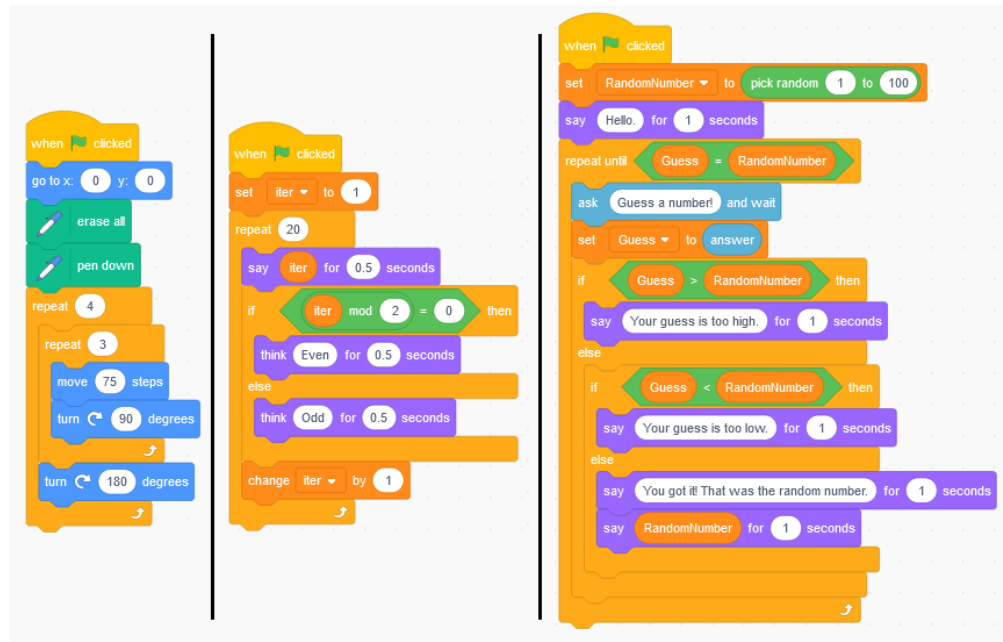
Figure A1. The three original algorithms that the Generic Tasks were derived from ( left ). Plus: The sprite draws a plus sign (middle ). Odd–Even: The sprite goes through the numbers from 1 until 20 and thinks about whether the number is odd or even ( right ). Guess a number: The user can guess a number.